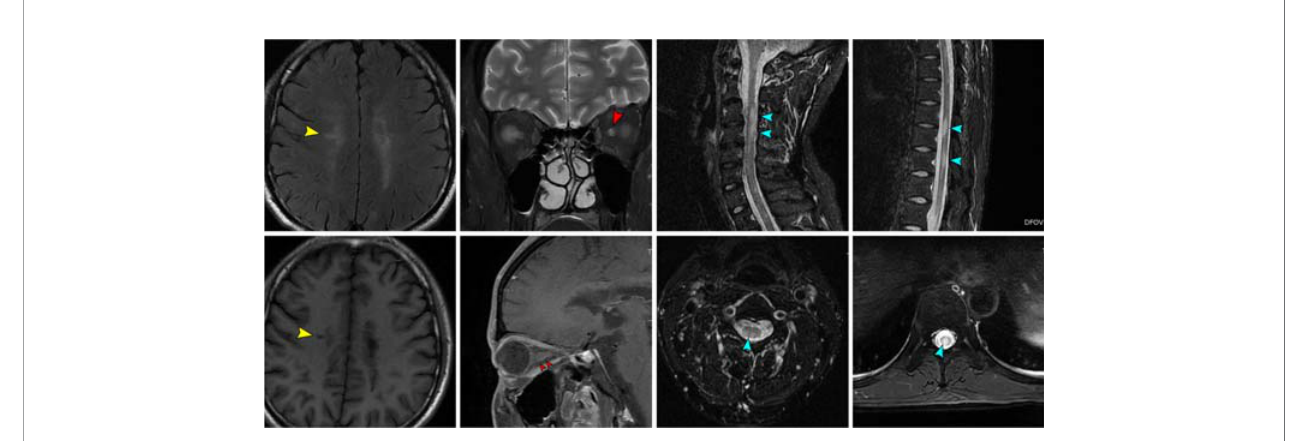
FIGURE 3 | The patient ’ s MR images which